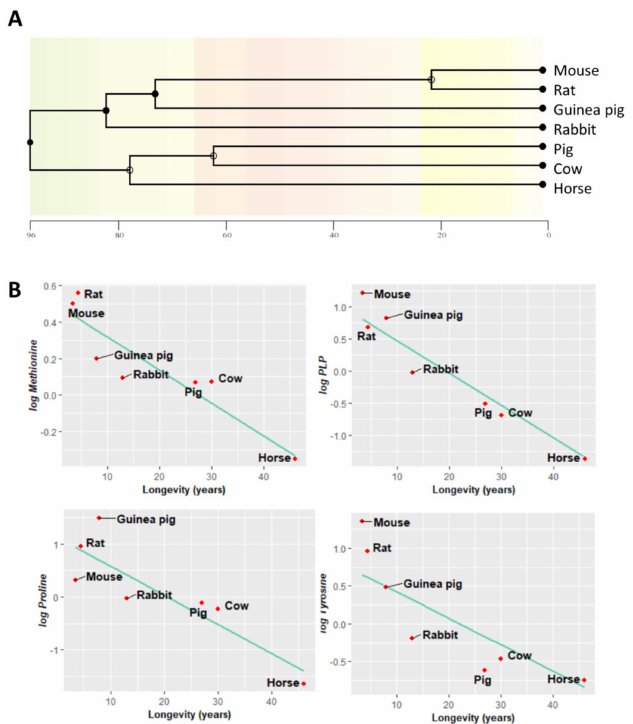
Figure 6. Heart metabolites negatively correlate with mammalian longevity after correcting for phylogenetic relationships. ( A ) Phylogenetic tree of the species studied; the abscissa is expressed in millions of years ago. ( B ) Phylogenetic generalized least squares regression (PGLS) between longevity and the heart concentration of methionine-related metabolites, amino acids, and TCA cycle intermediates. The minimum significance level was set at p < 0.05. All metabolites were log-transformed in order to fulfil the assumptions of